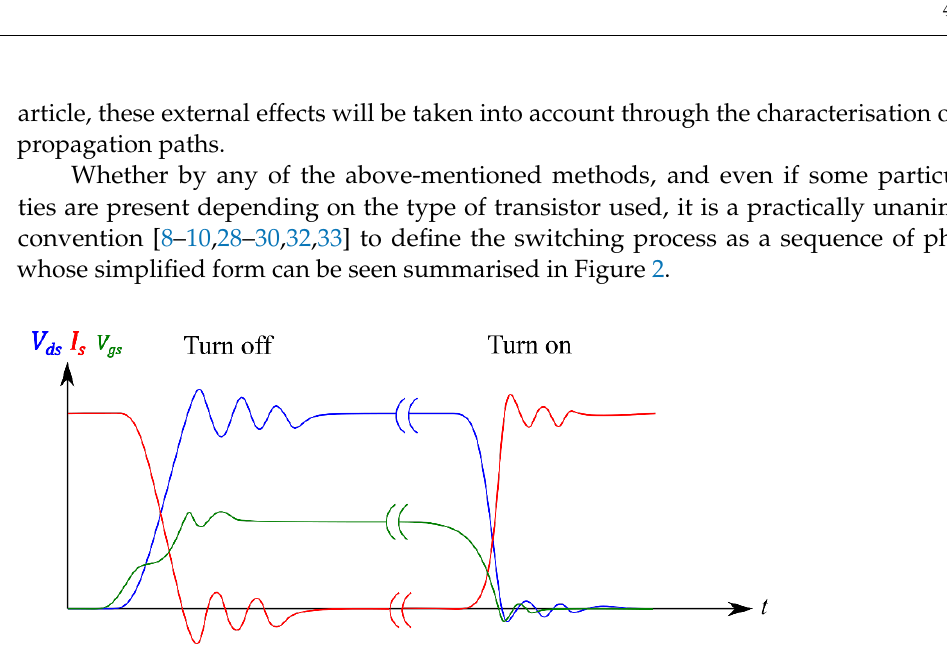
Figure 2. Basic current and voltage switching waves ’ time domain characteristics.